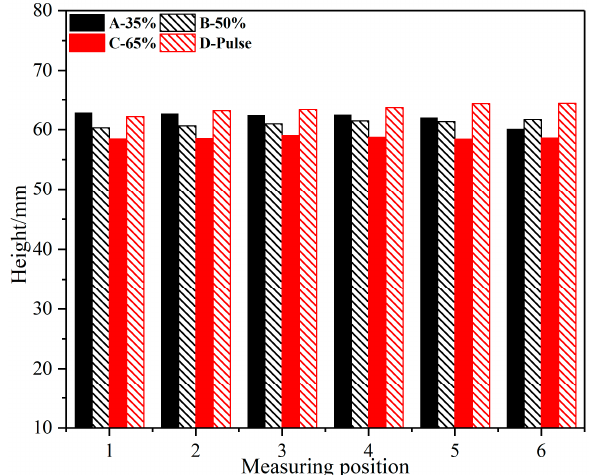
Figure 6. Six-point heights of four parts.